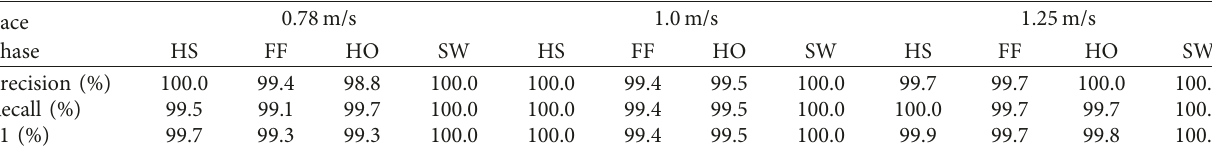
Table 5: Summary of classification performance of VWI-DNN at unsynchronized speed.